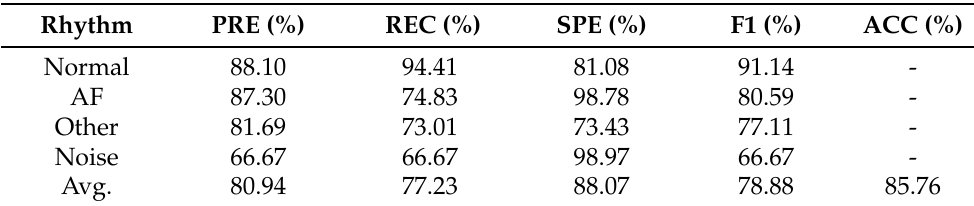
Table 5. Classification performance for Normal, AF, Other and Noise rhythm using MCNN-BLSTM ( l = 25 s) on the PhysioNet/CinC Challenge 2017.